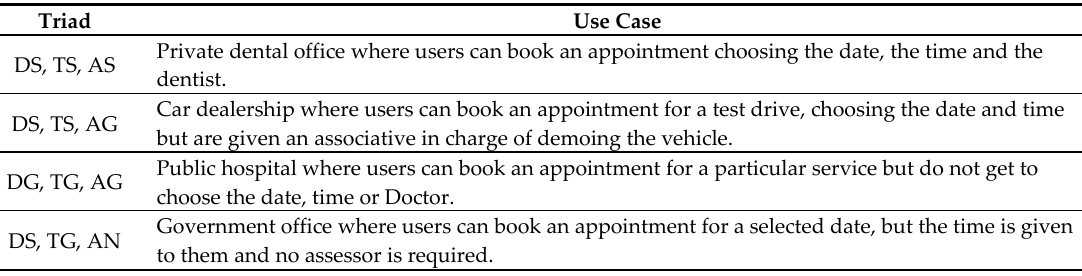
Table 1. Common Use Cases for